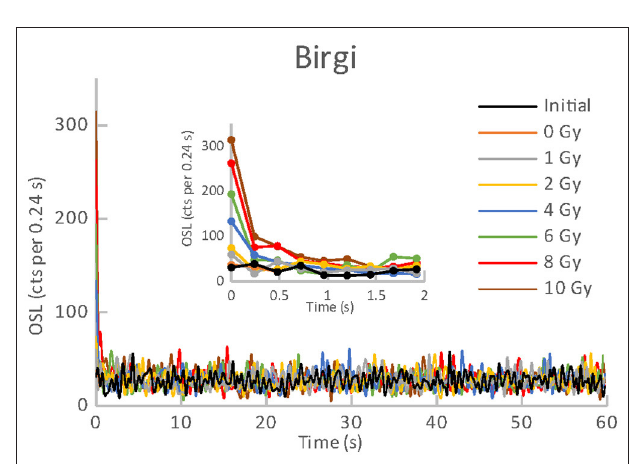
FIGURE 2 | OSL curves for the initial readout and subsequent post-irradiations readouts of an aliquot of Panadol Extra.